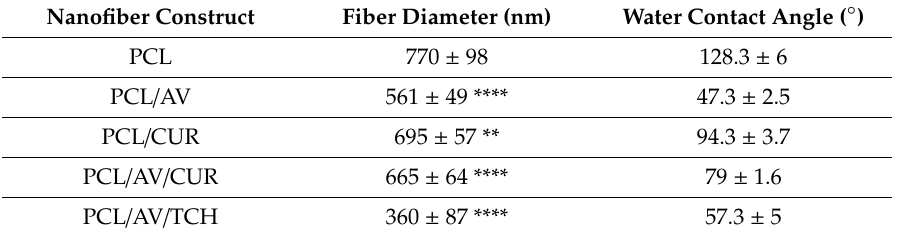
Figure 1. SEM images for biocomposite nanofibrous scaffolds ( a ) poly- ε -caprolactone (PCL), ( b ) PCL/ aloe vera (AV), ( c ) PCL/ curcumin (CUR), ( d ) PCL/AV/CUR ( e ) PCL/AV/ tetracycline hydrochloride (TCH). Scale bar = 1µm. Table 1. Fiber diameter and water contact angle of nanofibrous sca ff olds. ** p < 0.01, **** p <